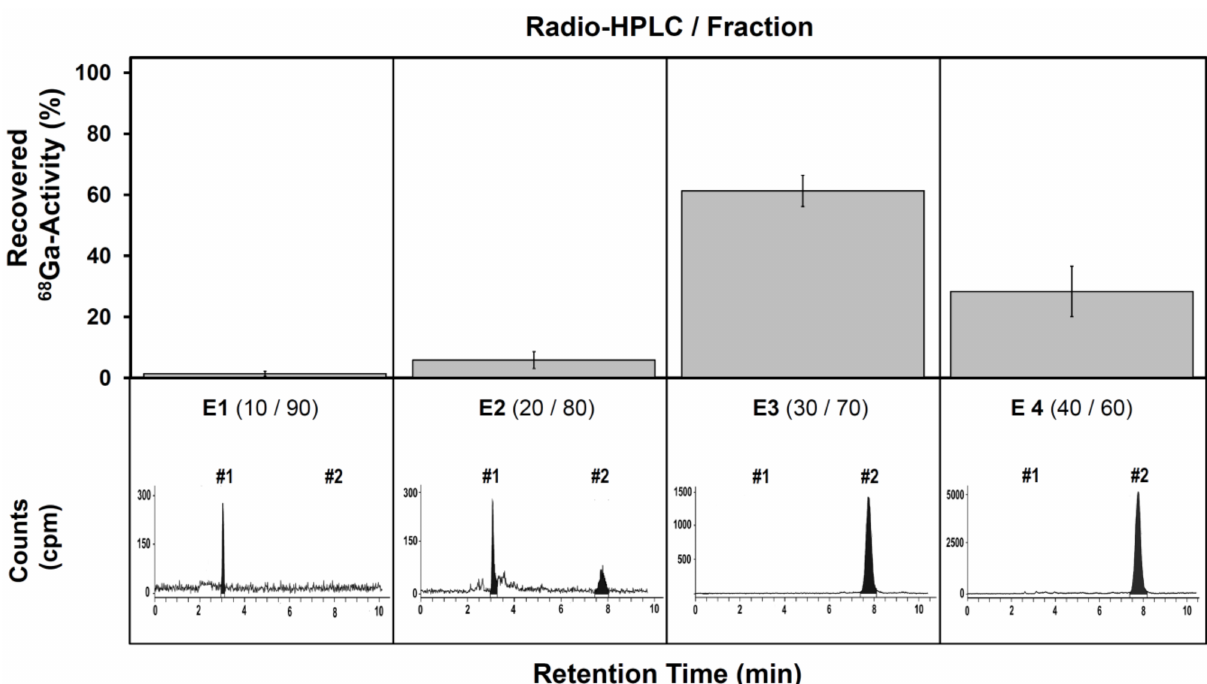
Figure 4. Suggested procedure for non-quantitative [ 68 Ga]Ga-DOTA-[Thi 8 , Met(O 2 ) 11 ]SP preparations addressing the recovery of 68 Ga-product from a C18-SPE matrix. Amounts of recovered 68 Ga-activity ( top ) related to the total C18 SPE retained radioactivity prior to sequential treatment with different ethanol/saline solution (quantified by gamma counting; n = 3). The corresponding radio-HPLC chromatogram ( bottom ) showing the constitution of the recovered activity in reference to [ 68 Ga]Ga-DOTA-[Thi 8 , Met(O 2 ) 11 ]SP (#2) and [ 68 Ga]Ga 3+ (#1). The ethanol amounts used in E3 and E4 were able to recover pure [ 68 Ga]Ga-DOTA-[Thi 8 , Met(O 2 ) 11 ]. Non-recoverable 68 Ga-amounts remaining on the C18 SPE unit were